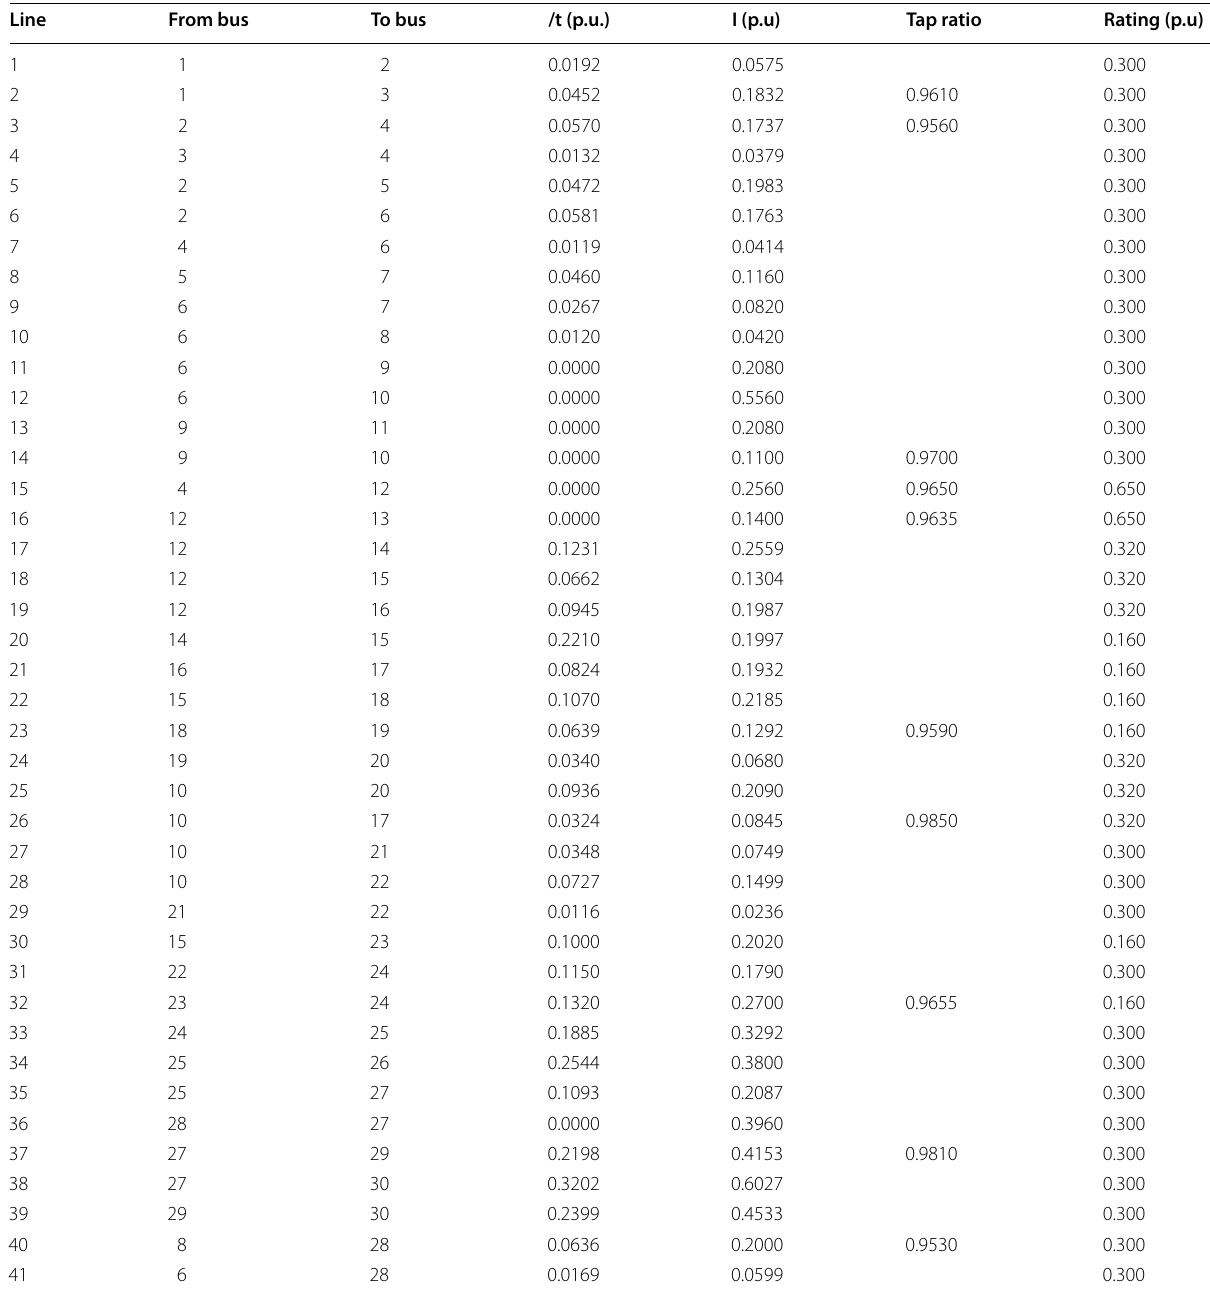
Table 14 Line parameter of IEEE-30 bus test